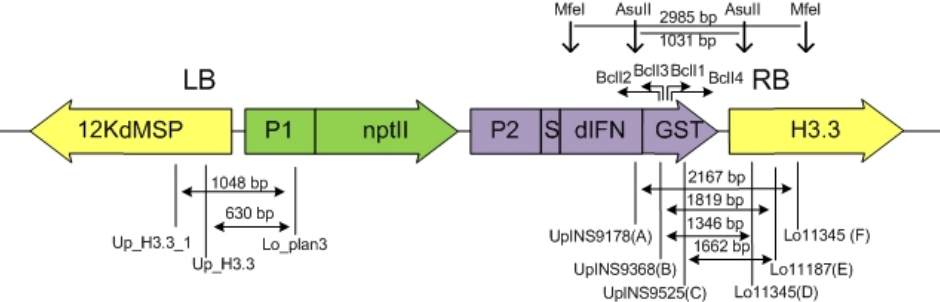
Figure 3. Mutual arrangement of primers and restriction endonucleases used for the analysis of plant and plasmid DNA junctions. Designations: LB and RB, left and right borders of plant DNA; P1-P-NOS promoter of A. tumefaciens nopaline synthase; P2, CaMV35S promoter of the cauliflower mosaic virus; nptII, neomycin phosphotransferase II gene providing plant cell resistance to kana-